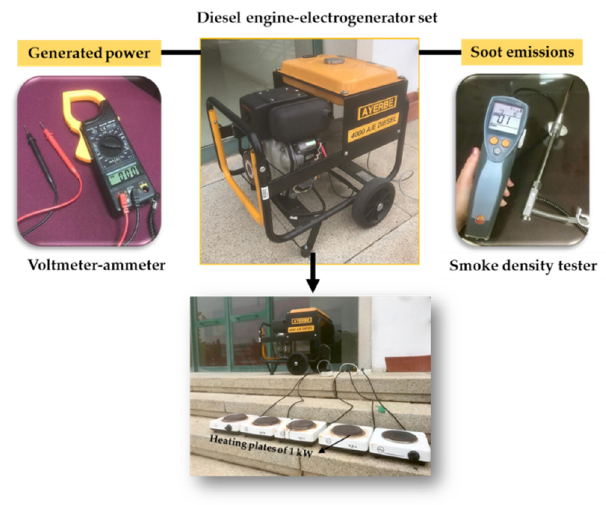
Figure 2. Mechanical and environmental characterization of diesel engine-electrogenerator set [17].